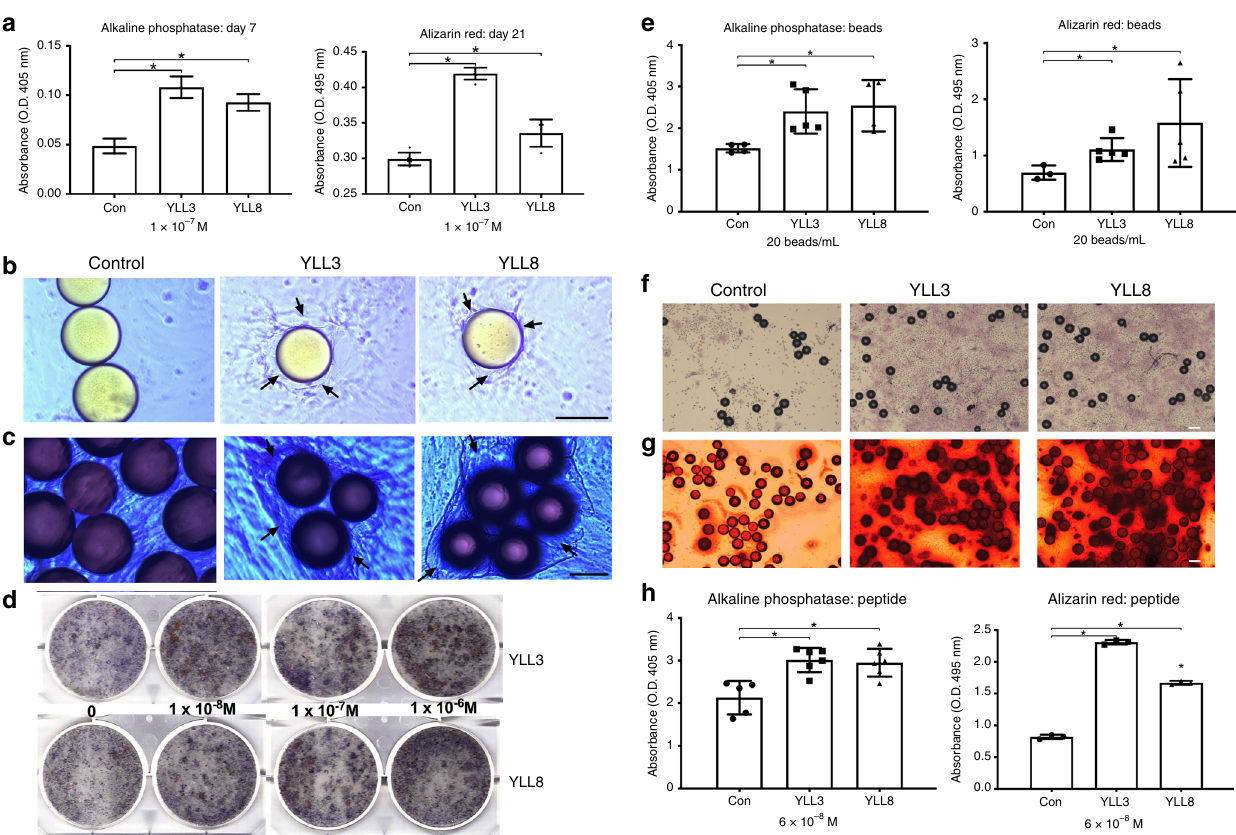
Fig. 2 Osteogenic peptides YLL3 and YLL8-binding af fi nities towards osteoprogenitor cells and in vitro osteogenic differentiation property. BMSCs obtained from mouse or human were plated on collagen-I coated wells and incubated with auto fl uorescence-quenched beads displaying YLL3 or YLL8 in osteogenic media. a Quantitative measurement of alkaline phosphatase (ALP) at day 7 and alizarin red (AR) levels at day 21 in human-derived cell cultures treated with YLL3 or YLL8. Columns represented individual values in each group and the error bars represented standard deviations. N = 3 biologically independent samples/group. * p < 0.05 between the treated groups versus control (Con) using one-way ANOVA followed by Dunnett ’ s multiple comparison post hoc test. b Representative images of binding af fi nities with human-derived MSCs after co-cultured with beads displaying YLL3 or YLL8 for 12 h. Scale bar = 100 µ m. c Representative images of ALP staining in human-derived MSCs cultured with beads displaying YLL3 or YLL8 for 14 days. Scale bar = 100 µ m. d Human-derived MSCs were cultured with YLL3, and YLL8 peptides at indicated concentration in osteogenic media for 10 days and stained for ALP. e Quantitative measurement of ALP at day 7 and AR at day 21 in mouse-derived cell cultures. Columns represented individual values in each group and the error bars represented standard deviations. N = 3 biologically independent samples in control-treated groups and n = 5 biologically independent samples in YLL3 and YLL8-treated groups. * p < 0.05 between the treated groups versus control (Con) using one-way ANOVA followed by Dunnett ’ s multiple comparison post hoc test. f Representative images of ALP staining in mouse BMSCs cultured with beads displaying YLL3 or YLL8 at day 10. Scale bar = 100 µ m. g Representative images of AR staining in mouse BMSCs cultured with beads displaying YLL3 or YLL8 at day 21. Scale bar = 100 µ m. h Mouse BMSCs were cultured with YLL3 and YLL8 at 6 x 10 − 8 M in osteogenic media for 10 or 21 days to measure ALP levels at day 10, and AR levels at day 21. Columns represented individual values in each group and the error bars represented standard deviations. N = 5 biologically independent samples in control-treated groups, and n = 6 biologically independent samples in YLL3 and YLL8-treated groups. * p < 0.01 between the treated groups versus control (Con) using one-way ANOVA followed by Dunnett ’ s multiple comparison post hoc